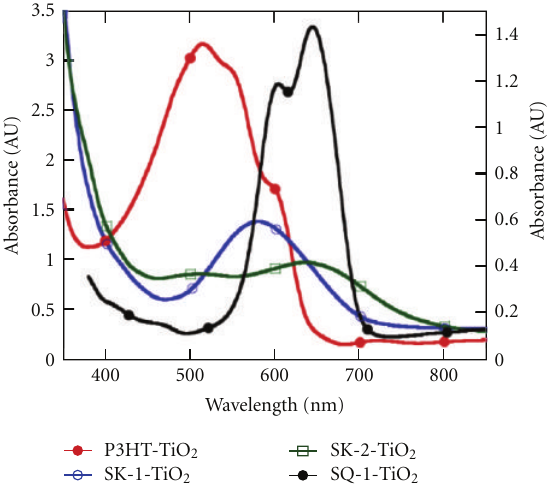
Figure 9: Optical absorbance of SK-1-, SK-2-, and SQ-1-sensitized TiO 2 nanotube arrays, and P3HT intercalated nanotube arrays without dye sensitization. The nanotube arrays had an average pore size of 35nm and tube length of 600–700 nm. Reprinted with permission from [7,